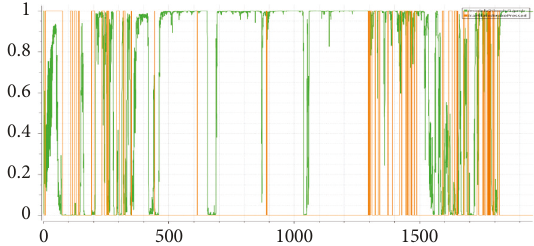
Figure 8: T1D2 lead car detection and braking.